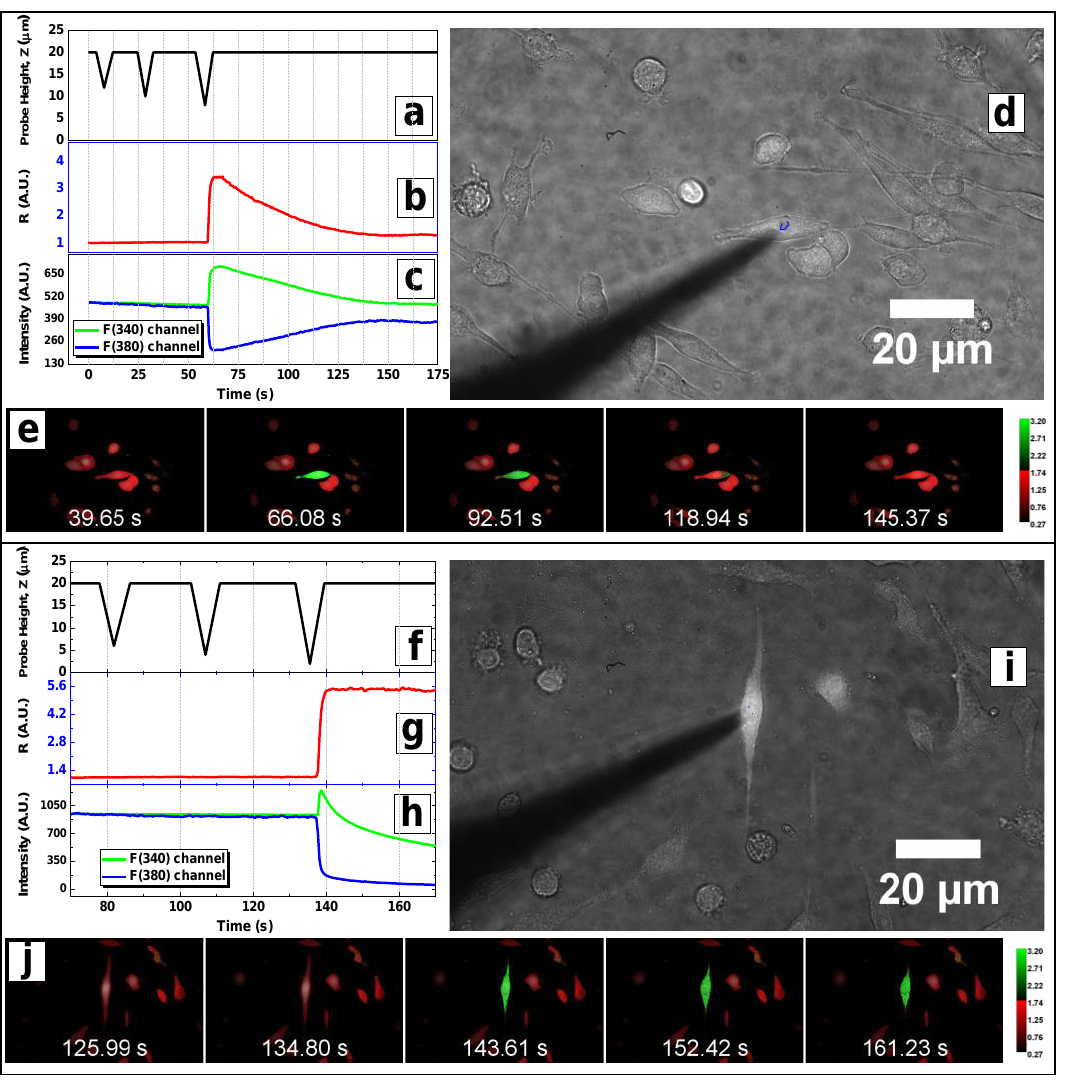
Figure 5. Single-cell microindentation of Piezo1-A1 cells: the changes of intracellular Ca 2+ concentration are monitored using ratiometric fluorescence microscopy; examples of a responsive ( a – e ) and an unresponsive cell ( f – i , j ) are reported. Cell-indenter glass probe is initially positioned above (h 0 = 20 μm) cell adhesion plane. Thus, deeper and deeper vertical displacements are actuated ( a , f ) until contact with cell membrane. Fluorescence intensity in respect to the excitation wavelengths of 340 nm and 380 nm is averaged over the intracellular area, and displayed in a plot of the fluorescence ratio R ( b , g ) or a channels plot ( c , h ). Both responsive and unresponsive cells are indented until membrane rupture occurs, resulting in a plateau in the R plot. Before the disruptive indentation, the cell presents a transient peak in R signal ( b ) with tFWHM~40 s (responsive). On the other hand, when no increase in the trace of R is observed before the plateau, i.e., the membrane rupture, cell is classified as unresponsive ( g ). The initial positioning of the probe requires a tip position visualisa- tion: bright-field microscopy is used to monitor the shadow of the tip ( d , i ), which can be moved